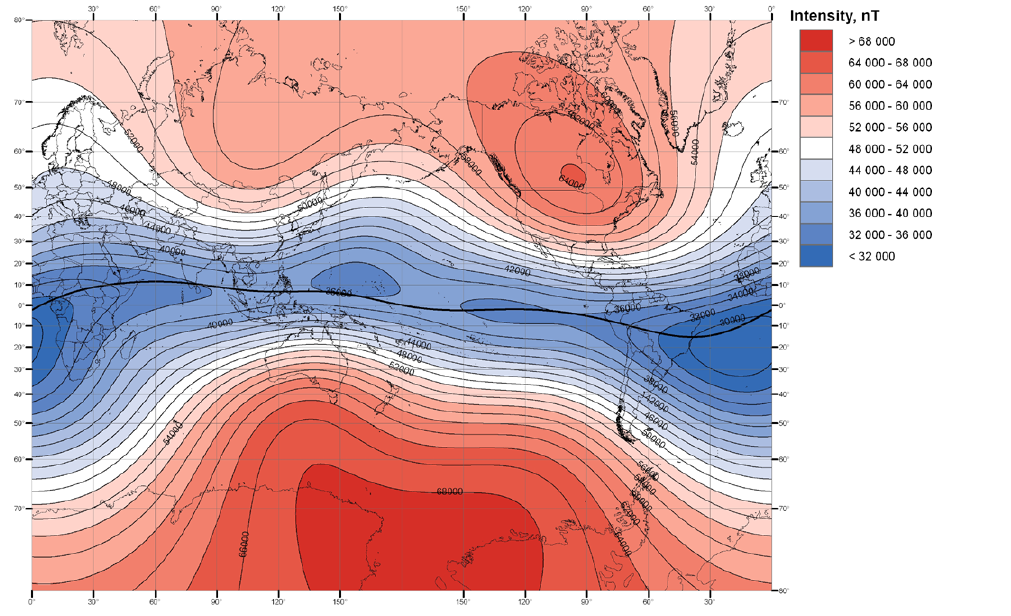
Figure 10. World map of total intensity for 1830 calculated according to gufm1 model. Magnetic equator is marked with a bold